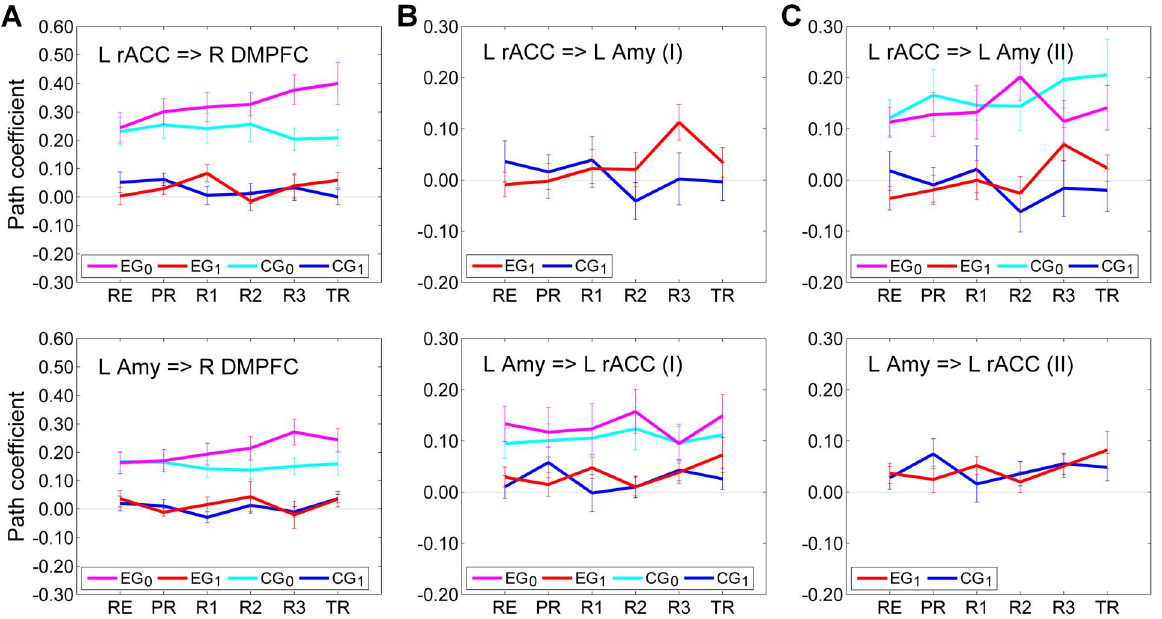
Figure 7 . Interactions suggested by the multivariate SVAR analyses for three ROIs. Results of the multivariate SVAR analyses for the system of three ROIs – the left rACC, the left amygdala, and the right DMPFC – with the models for instantaneous effects depicted in Fig. 5 B,C. (A) Effects that are common to both Model I (Fig. 5B) and Model II (Fig. 5C). (B) Interactions between the left rACC and the left amygdala in the SVAR analysis with Model I (Fig. 5B). (C) Interactions between the left rACC and the left amygdala in the SVAR analysis with Model II (Fig. 5C). Notations are the same as in Fig. 6.